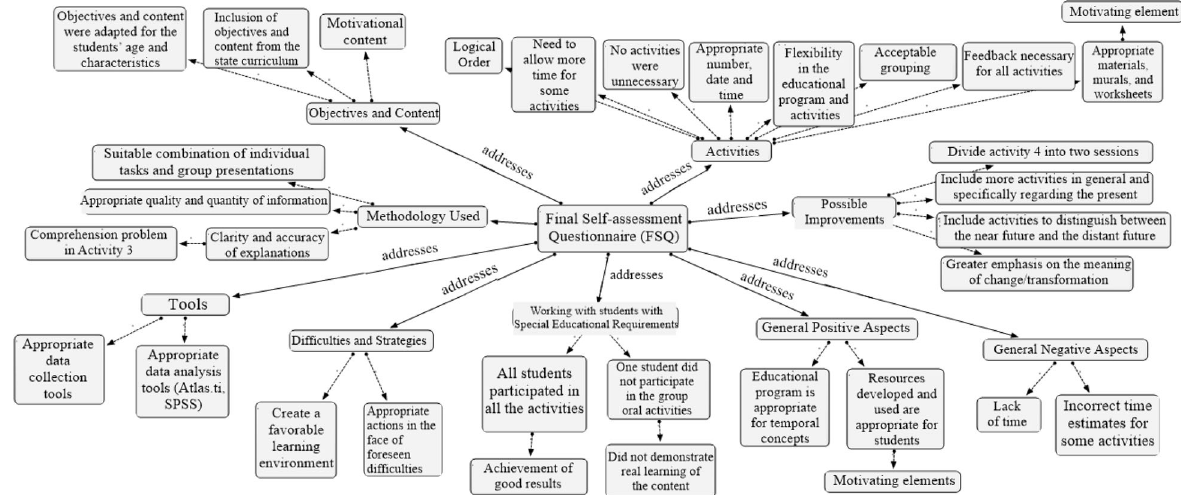
Fig. 5 Semantic network from the Final Self-assessment Questionnaire (FSQ). This fi gure shows a semantic network linking the Final Self-assessment Questionnaire with